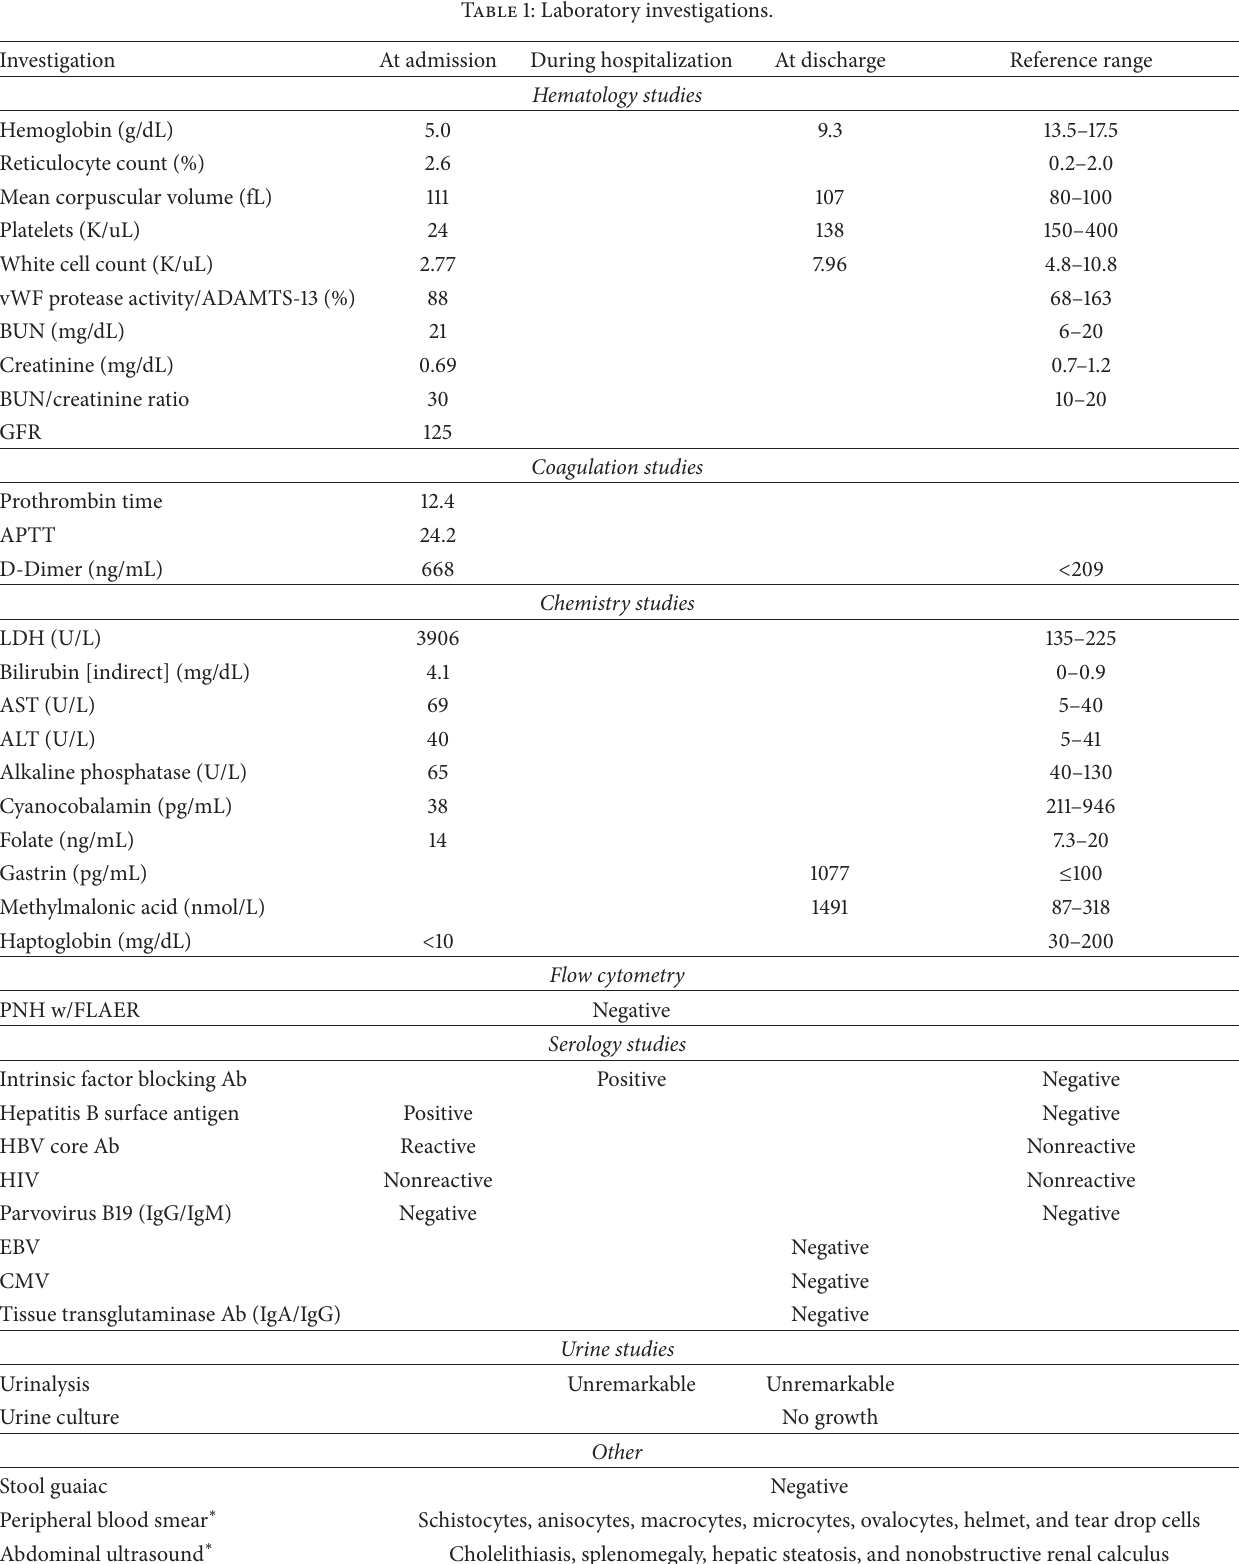
Table 1: Laboratory